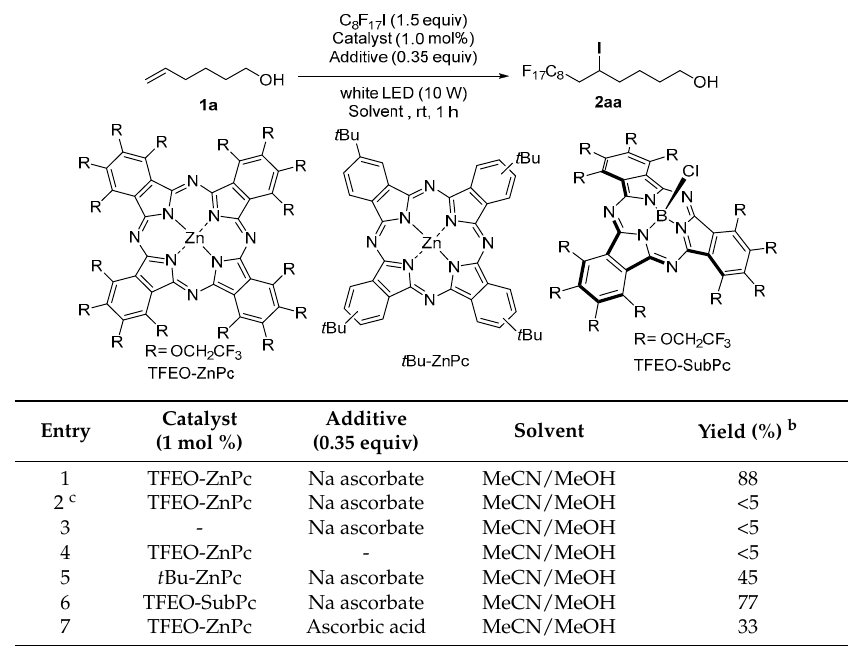
Table 1. Perfluorooctylation reaction of 1-hexenol with TFEO-ZnPc under visible light irradiation. a